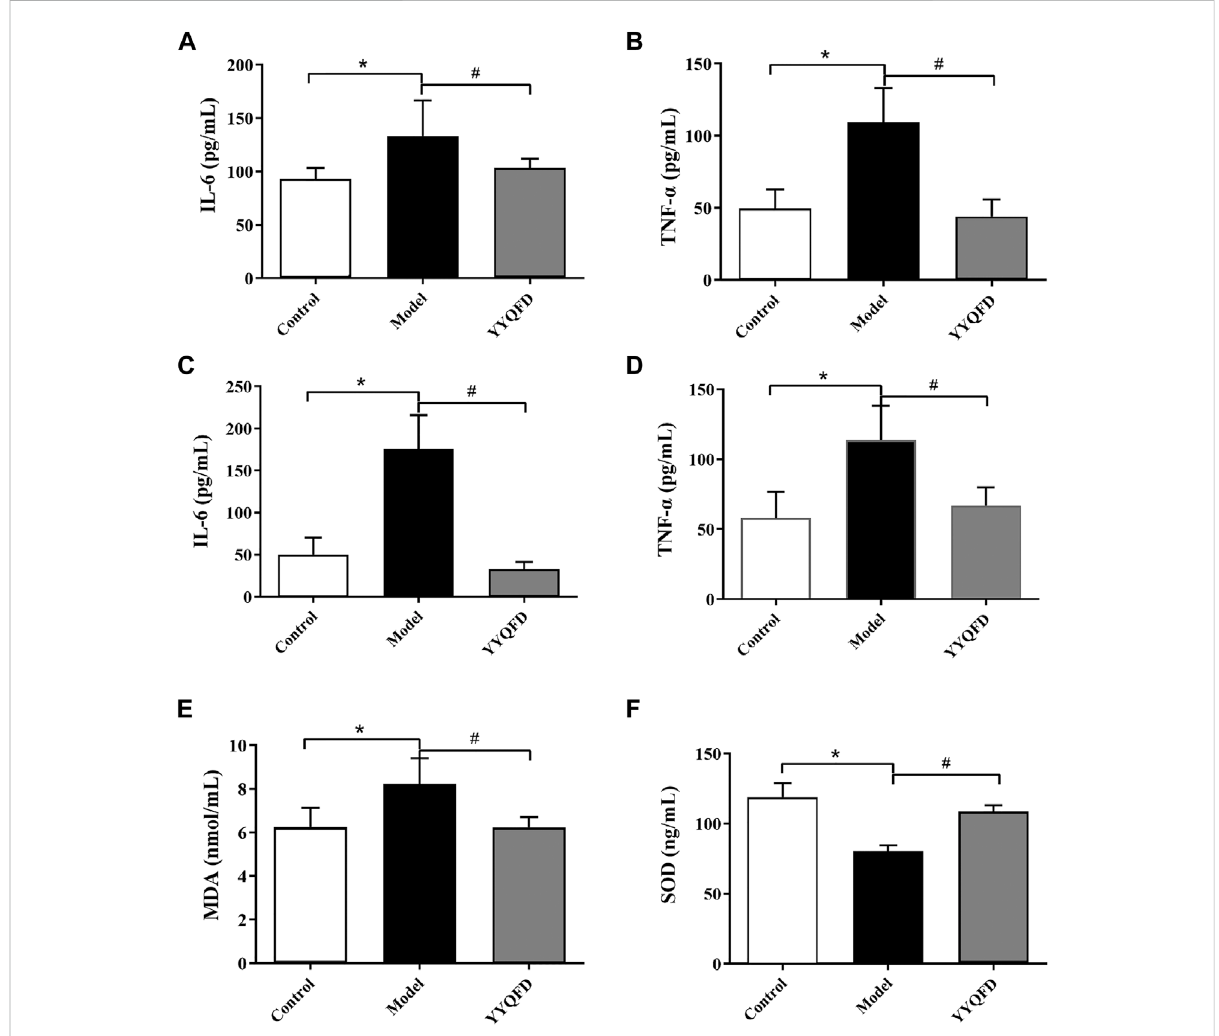
FIGURE 2 The IL-6, TNF- α ,MDA and SOD levels inBALF andserum measuredwith ELISA kits (A) and (B) IL-6 andTNF- α levels inBALF (C) and (D) IL-6and TNF- α levels in serum (E) and (F) MDA and SOD levels in serum. * p < 0.05 vs. control group, # p < 0.05 vs. model